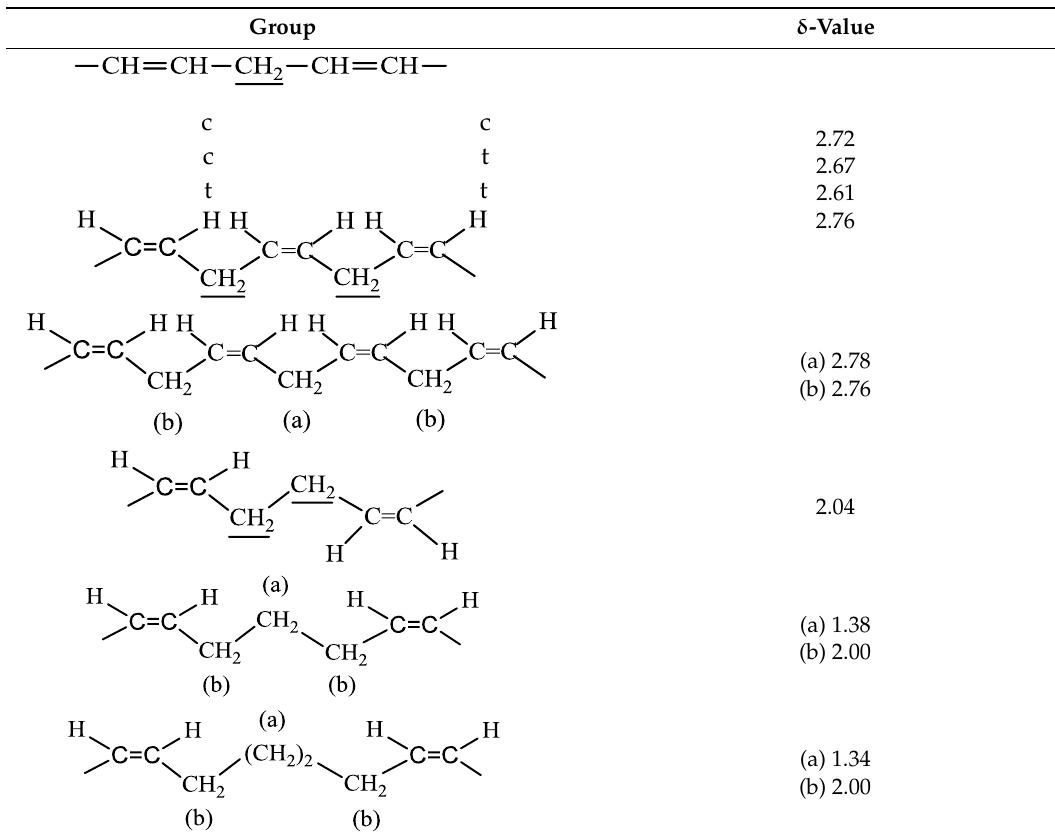
polyenoic fatty acids and esters (Table 8). This may be attributed to the position of the allylic protons